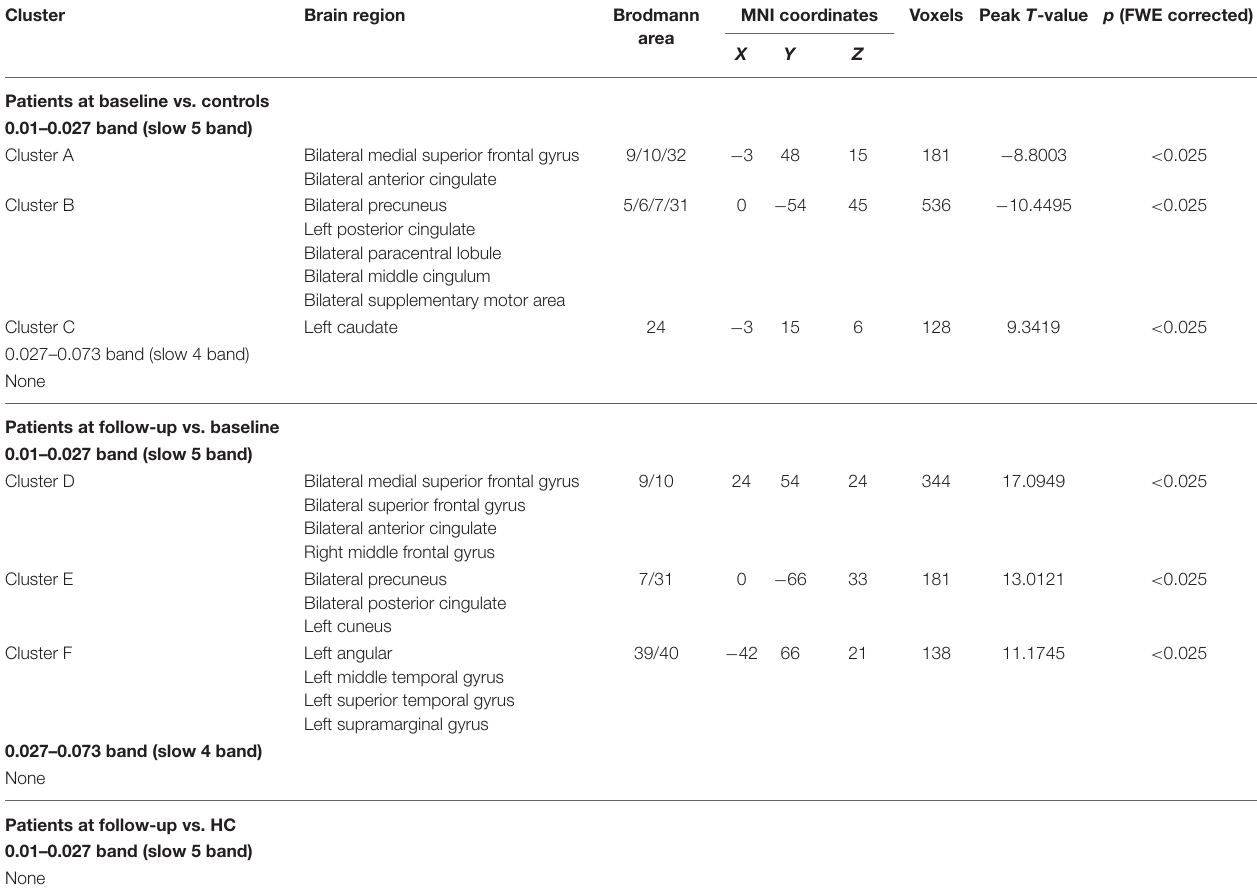
TABLE 2 | Baseline and longitudinal alterations of fALFF in bipolar II depression patients. Cluster Brain region Brodmann Patients at baseline vs. controls